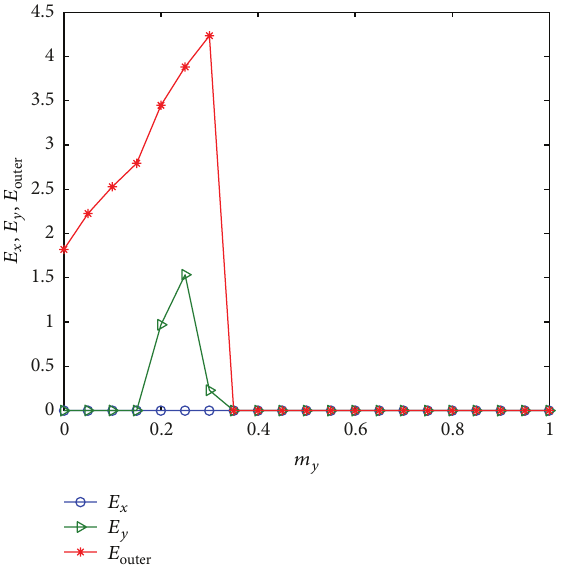
at 𝑡 = 400 on 𝑚 𝑦 for outer ≥ 0.35 , the inner and outer 𝑦